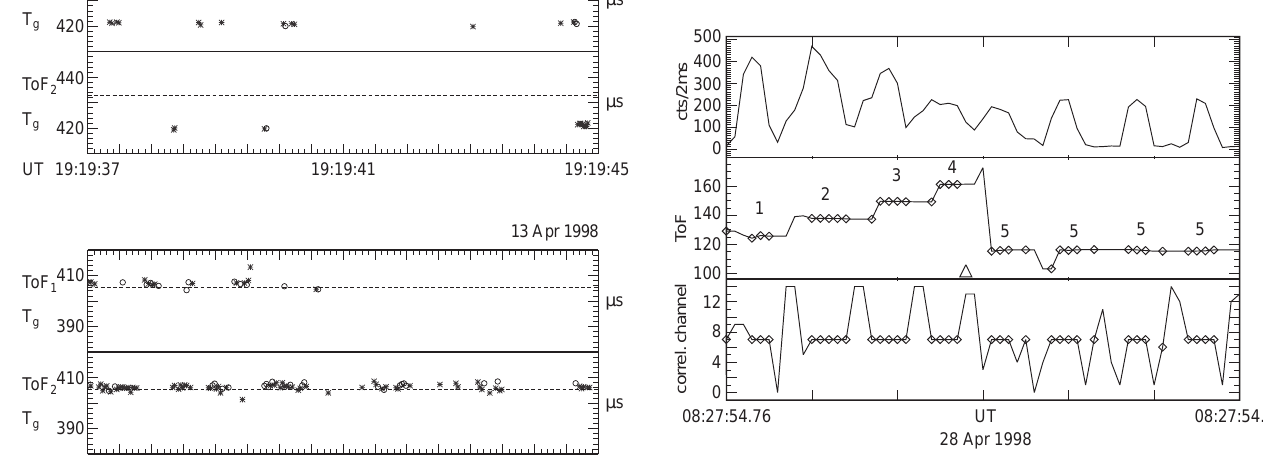
Fig. 3. Observations of electrons that have gyrated between one and five times, as indicated by the numbers in the middle panel . The figure shows, from top to bottom , the correlator counts accumulated in 2 ms; the apparent time-of-flight derived from the net code-shift (in l s); and the number of the correlator channel that the counts were recorded in. Channel number and time-of-flight are marked by diamonds if the counts appear in channel 7 (cid:6) 1, which is the tracking channel. The triangular symbol in the ToF panel marks the time of a correlator restart. As explained in the text, the (cid:25) 11.5 l s increment per added gyration is the gyro time modulo